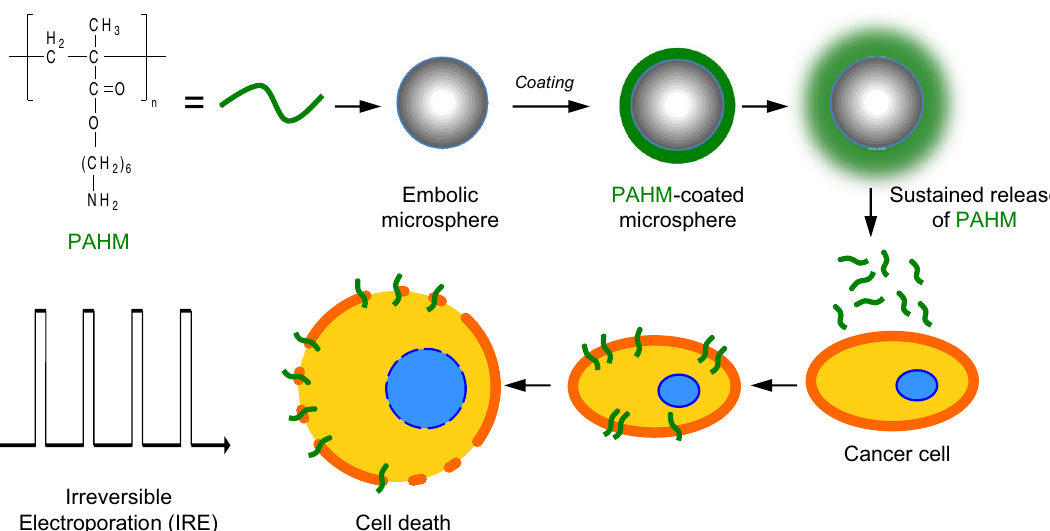
Figure 1. Schematic illustration of the combined killing of cancer cells by a synthetic membranolytic polymer (PAHM) and IRE. PAHM is coated onto embolic microspheres and then released to interact with cell membrane and sensitize the cells to IRE-induced membrane disruption and cell